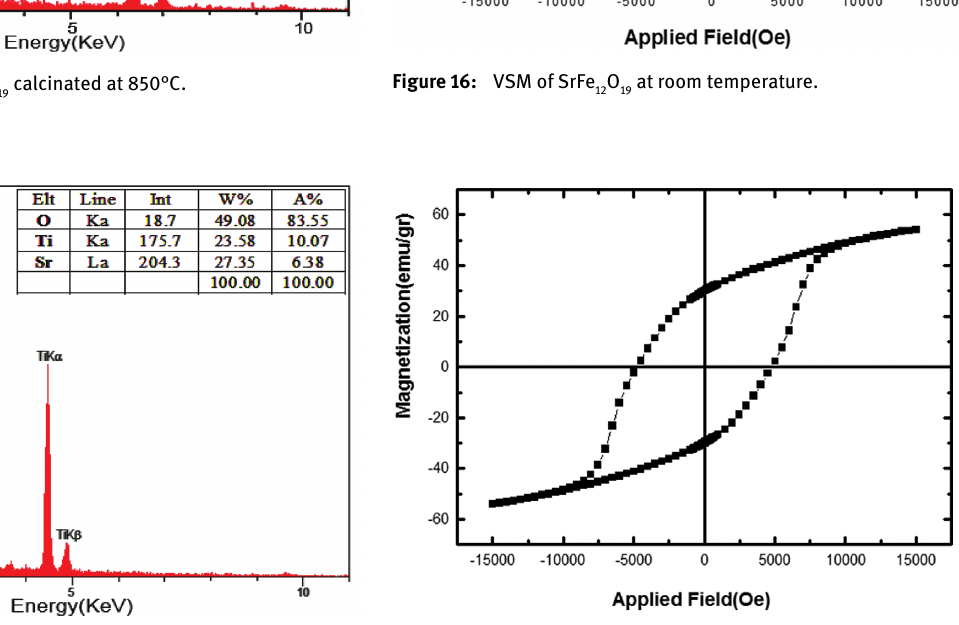
Figure 14: EDX of SrTiO